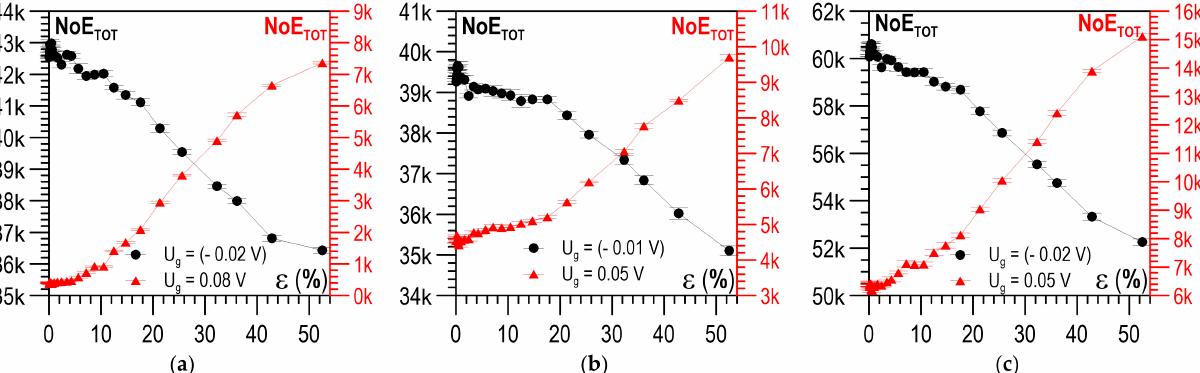
Figure 15. Relation between plastic deformation ε and mean NoE TOT values for different values of threshold voltage U g : ( a ) parallel direction; ( b ) perpendicular direction; ( c ) module of directions.